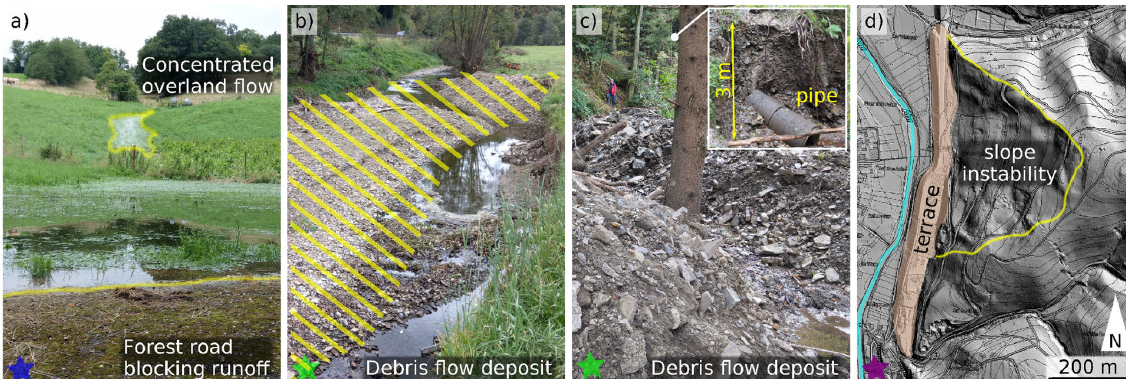
Figure 3. Landscape features emerging from the flood. For locations of these pictures, see star signatures in Fig. 1. (a) Focussed discharge along the hillslope causing deep and fast flow and thus efficient drainage in the background. However, the provided water is not routed downslope in the foreground but ponded by infrastructure and released at selected spots with increased erosive stream power. (b) Deposition area of the debris flow shown in panel (c) , injecting massive debris into the main channel (Trierbach), temporally blocking the stream and causing severe reorganisation of the hydraulic geometry. (c) Lateral deposits of the debris flow at the end of the valley-confined section. Inset shows upstream knickpoint formed by overspill and erosion of clogged drainage pipe (50cm diameter). (d) Old slope instability (yellow line) above a 20m high engineered terrace with industrial infrastructure on it. The terrace just east of the town of Antweiler had been undercut by the Ahr River during the